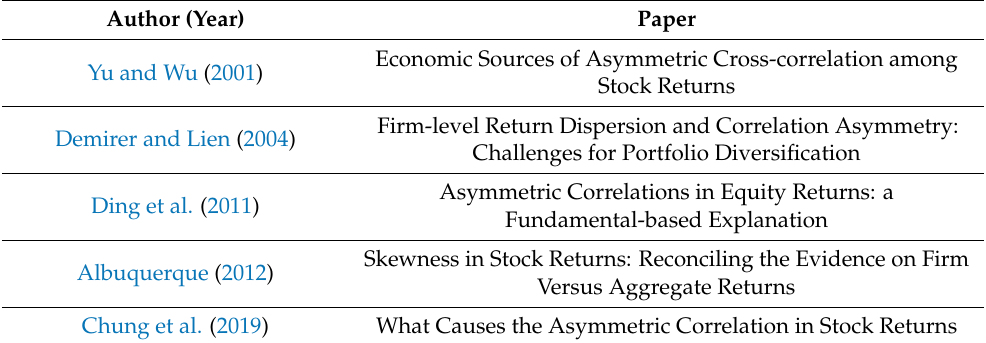
Table 4. Selected works on root cause of asymmetric